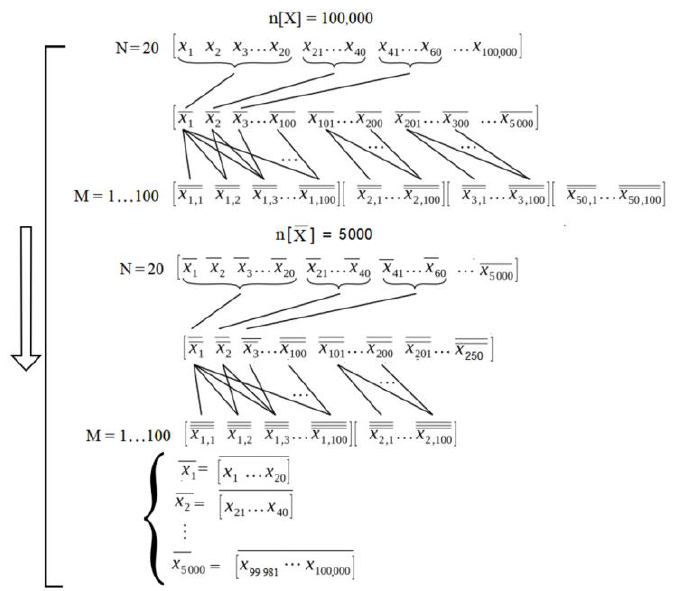
Figure 4. Diagram of the experimental procedure used to obtain the precision and accuracy of applying the CLT.